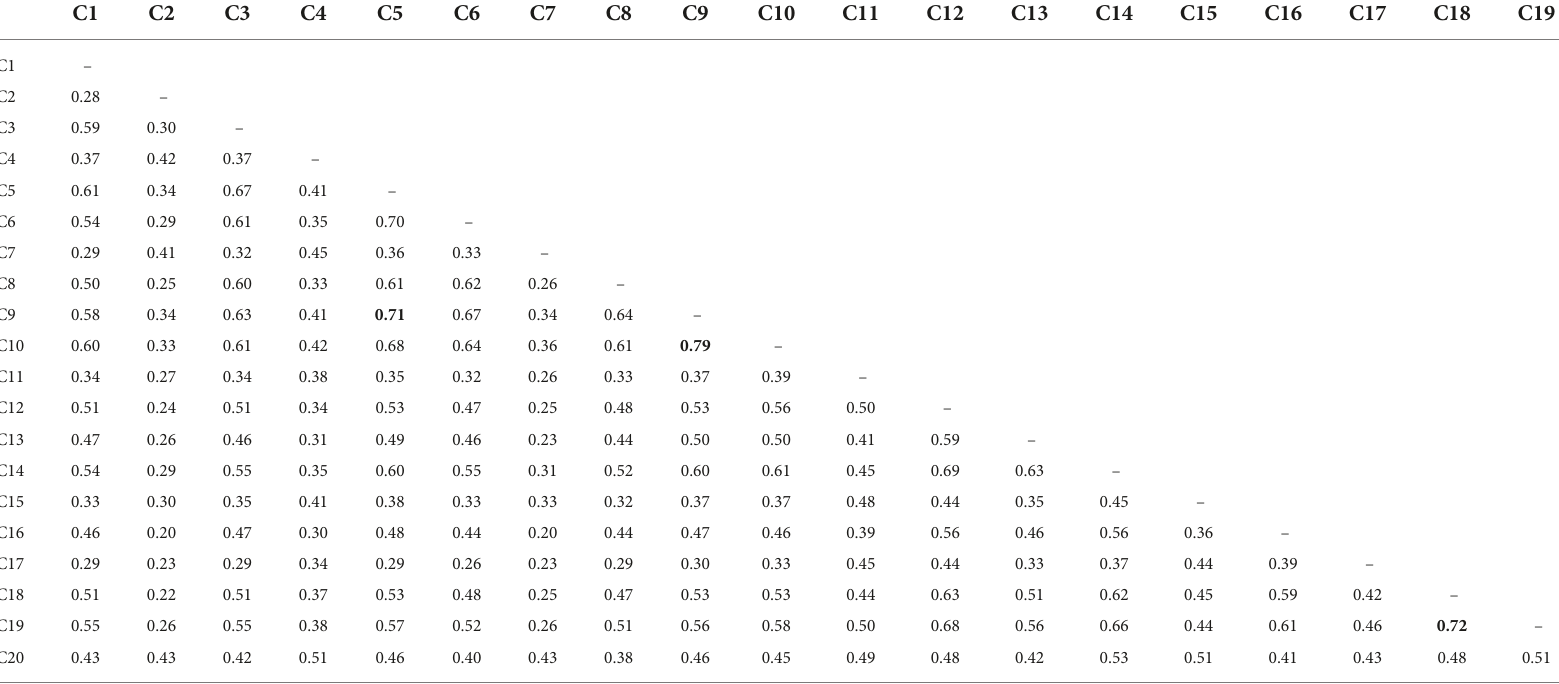
TABLE 3 Inter-item correlation matrix of the ATLG